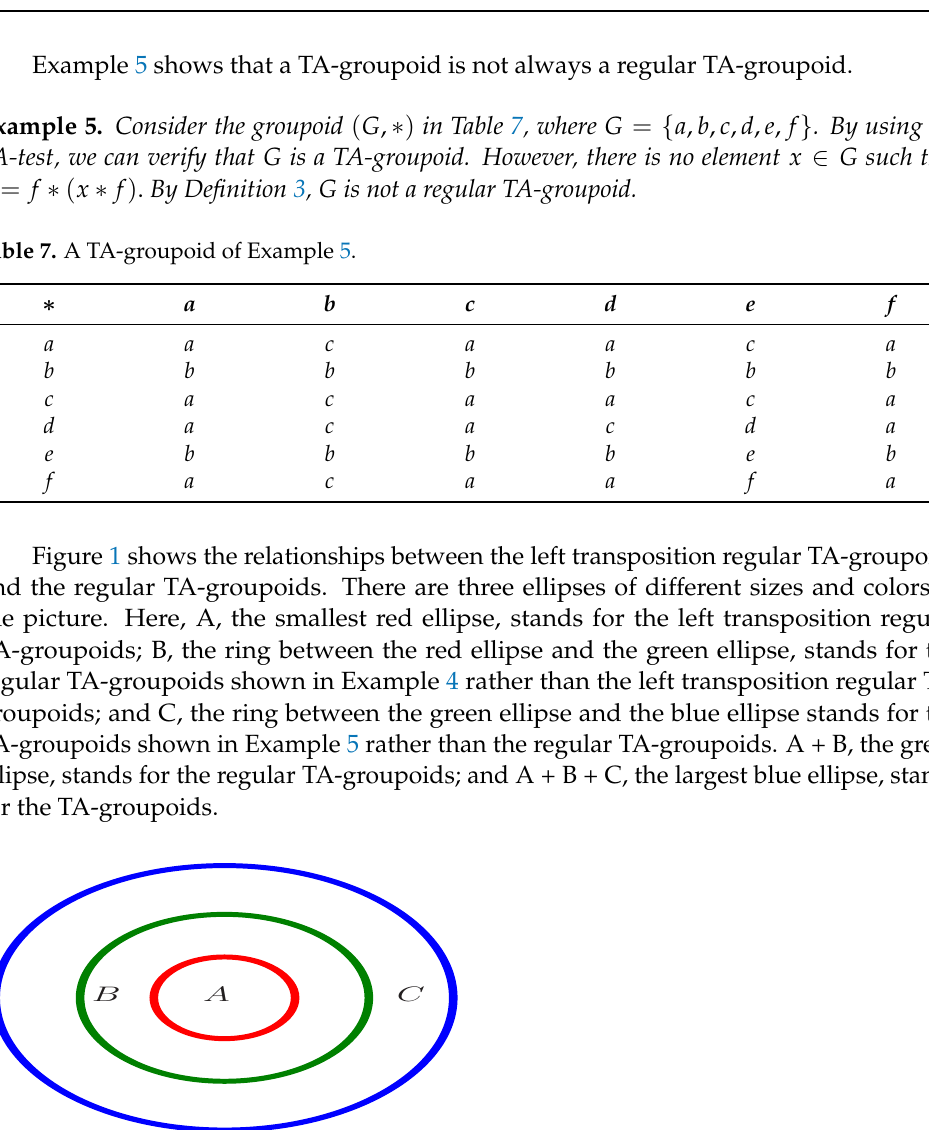
Figure 1. The relationships between the left transposition regular TA-groupoids and the regular